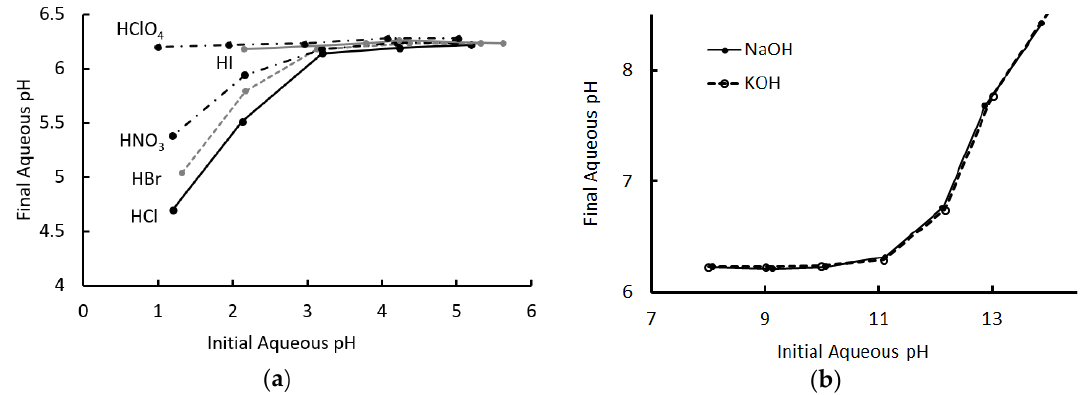
Figure 2. Final pH of solution after extraction, as a function of the initial pH. ( a ) Acid extraction. Data for the extraction of hydroiodic acid for pH < 2 was not reported, as the organic phase showed evidence of decomposition in this experiment. ( b ) Base extraction. Aqueous and organic phases were of equal volumes in these experiments.